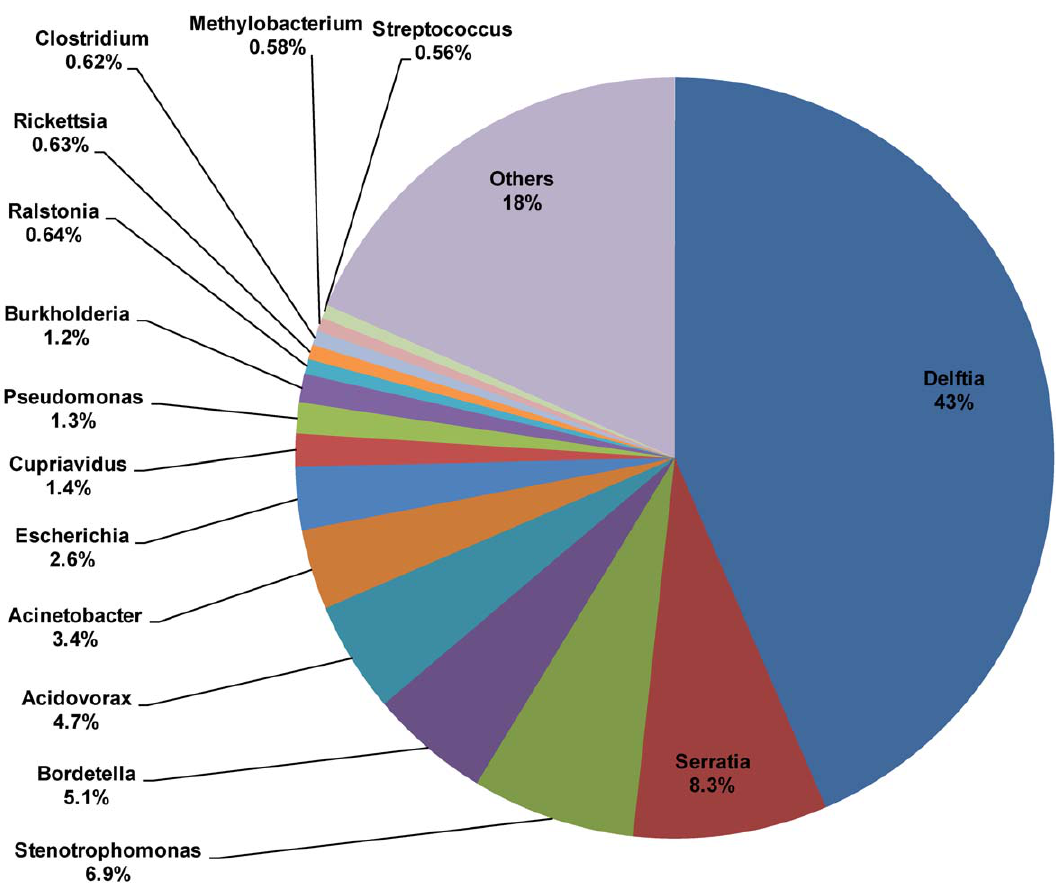
Figure 3. Diversity and phylogeny of bacterial symbionts in B.tabaci . Phylogenetic relationships of symbiotic bacteria in B.tabaci were resolved at the Genus levels.